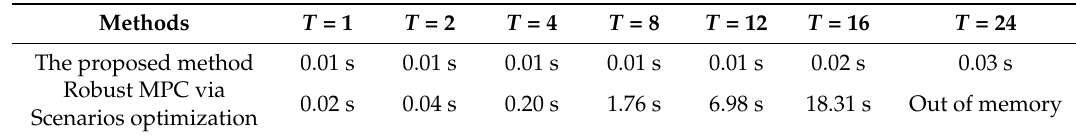
Table 3. Comparison on computational burden between the proposed method and robust MPC via scenarios optimization.